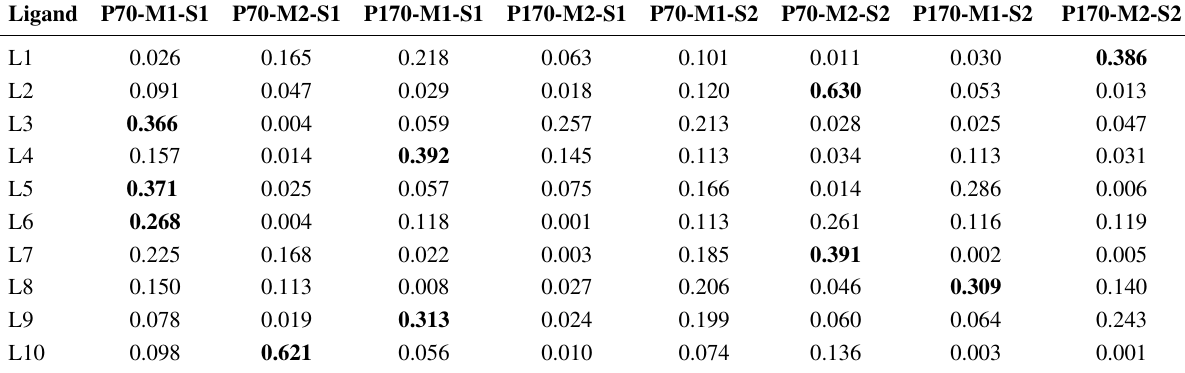
Table 6. Relative weights W of the different simulations i to the binding free energies i calculated for ligands L1–L10 using the S1–S2 LIE model (as obtained by combining results from all simulations).